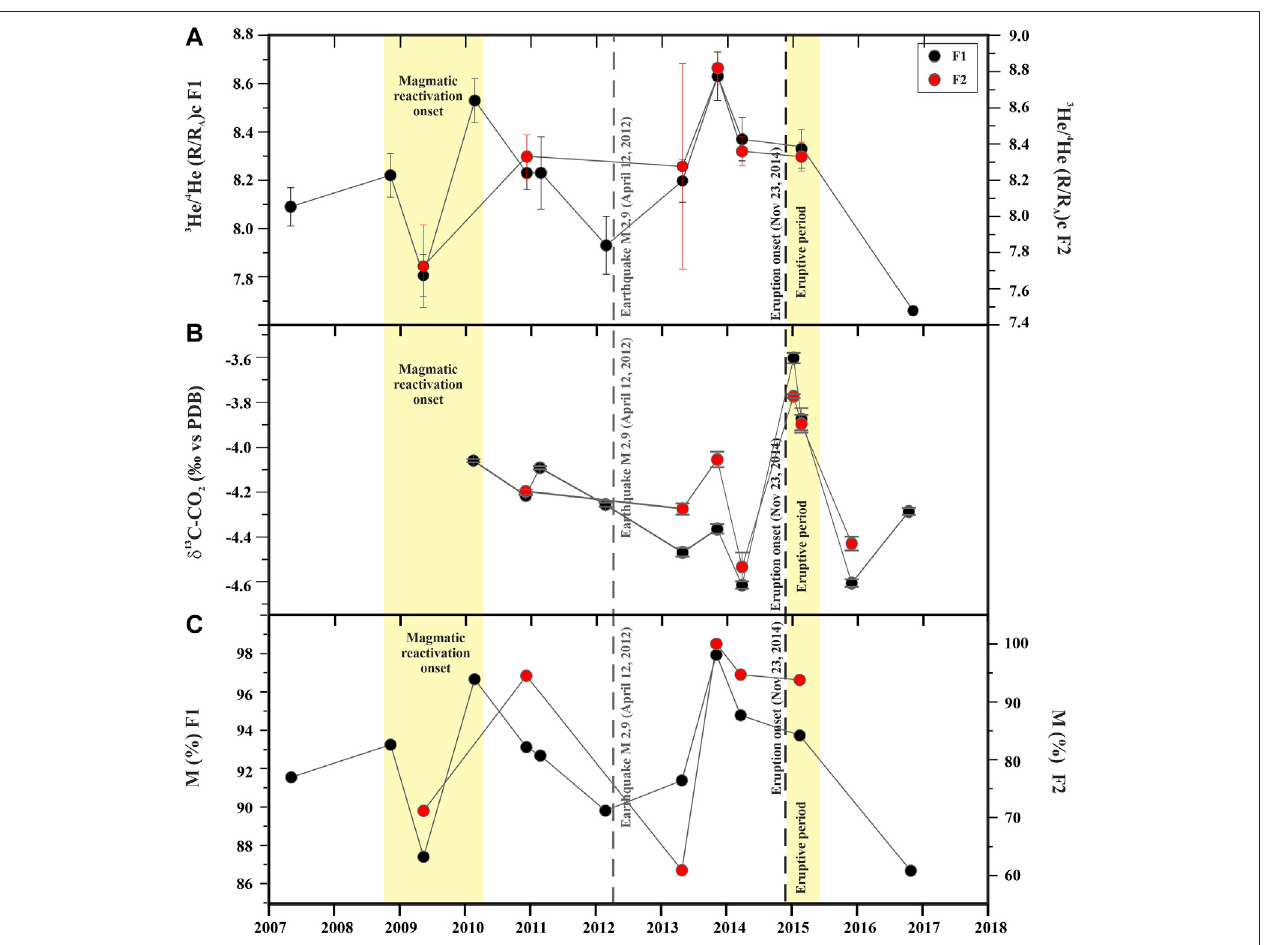
FIGURE 11 | Temporal evolution of (A) 3 He/ 4 He (R/R A ) corr , (B) δ 13 C – CO 2 ( ‰ vs. VPDB) and (C) magmatic He contribution (M), measured in the Pico do Fogo fumaroles discharges.